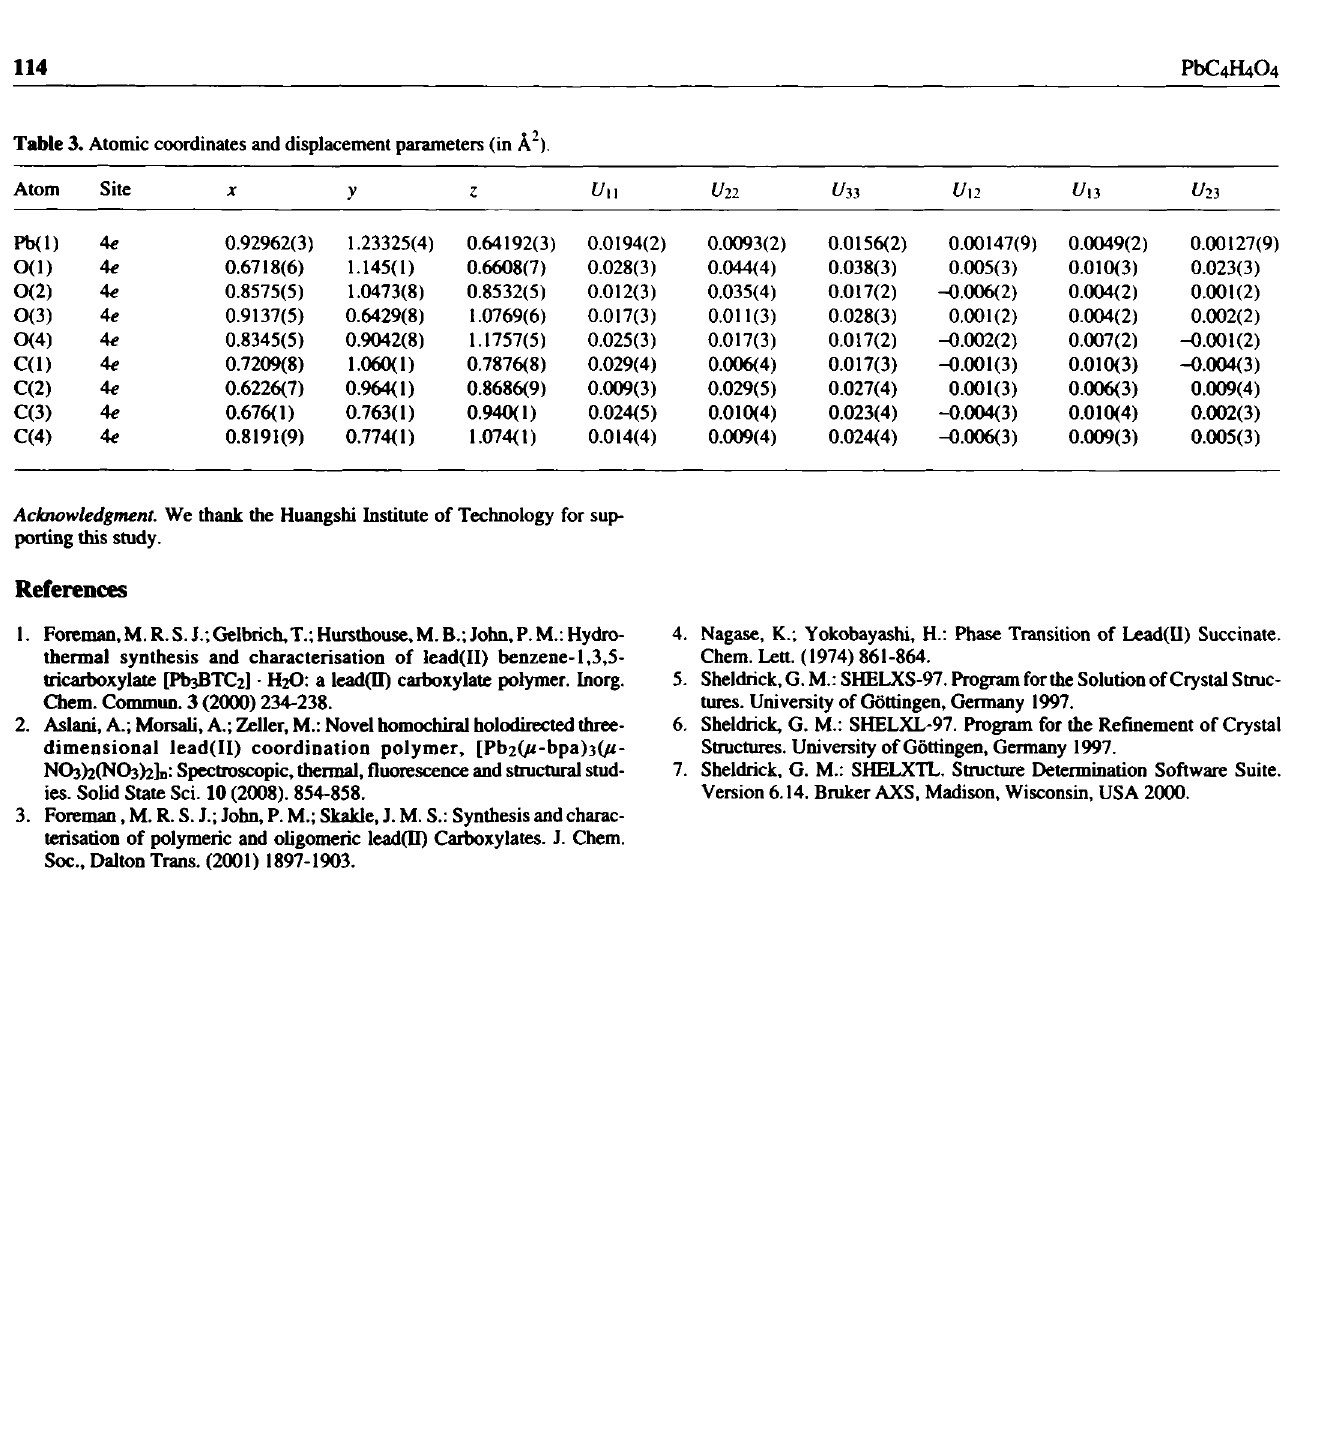
Table 3. Atomic coordinates and displacement parameters (in À 2